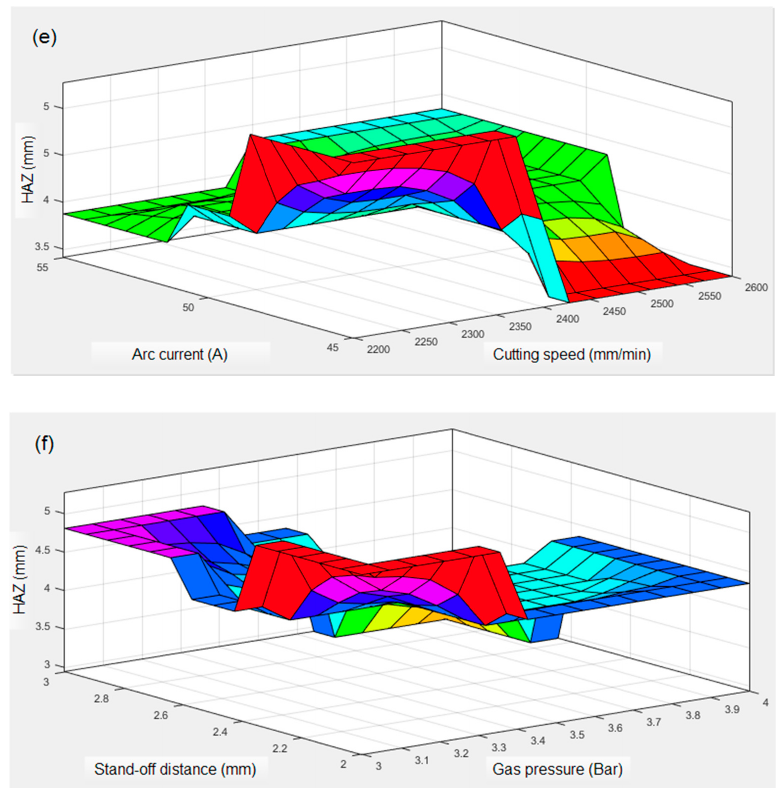
Figure 7. Three-dimensional (3D) fuzzy surface plots on various responses: ( a , b ) for MRR, ( c , d ) for KT, and ( e , f ) for HAZ.